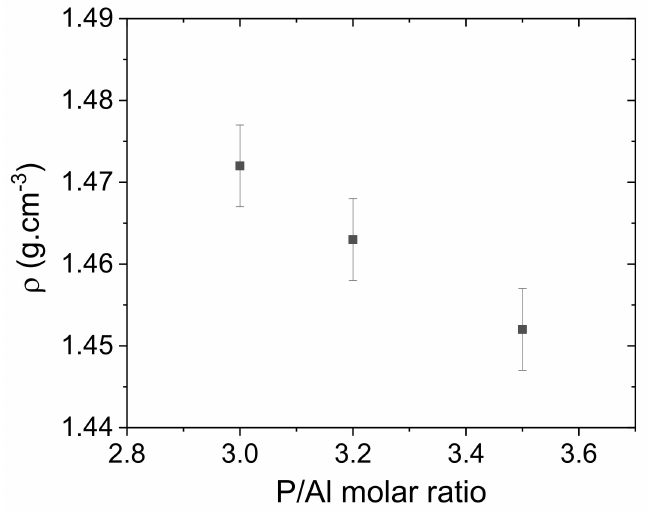
Figure 1. Density versus the P/Al molar ratio of the three solutions.